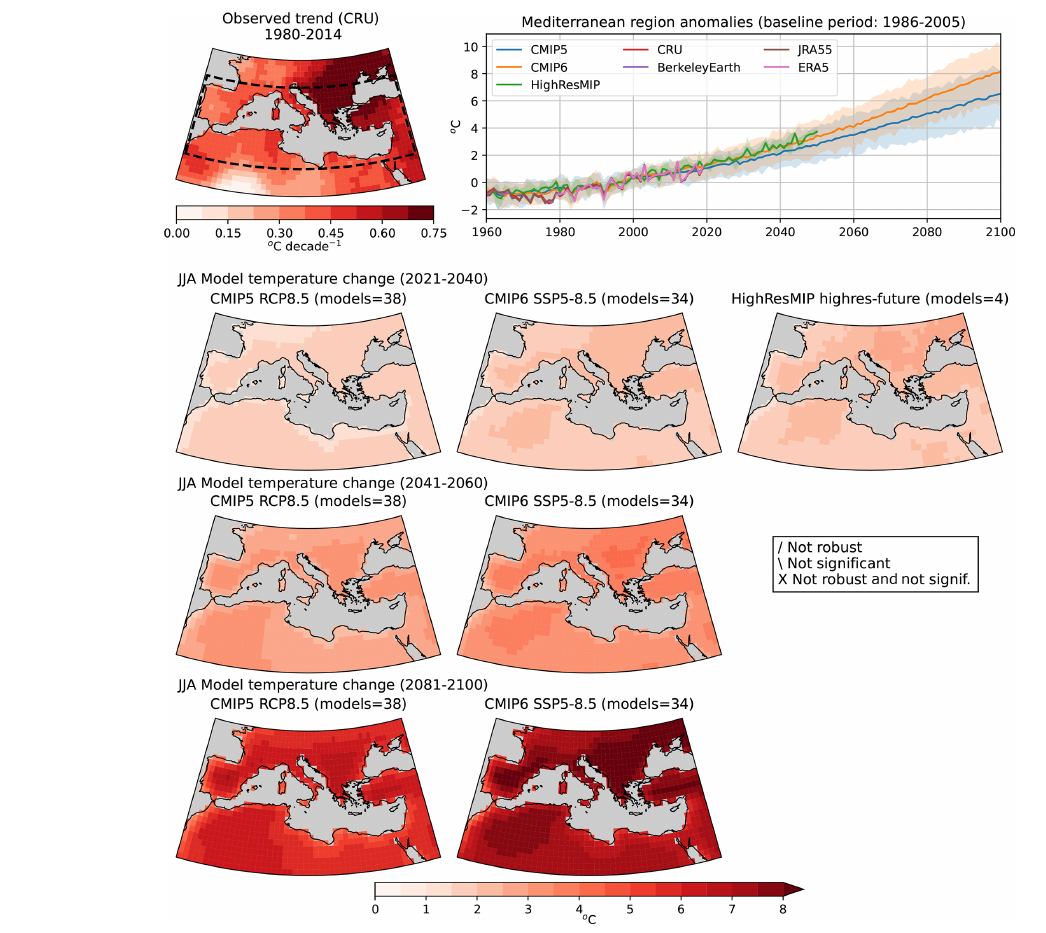
Figure 5. JJA (cid:49) TAS according to CMIP5, CMIP6 and HighResMIP ensemble means (columns) for the three relevant future periods (rows), under the RCP8.5 and SSP5-8.5 scenarios. The time series plot shows the anomalies in the Mediterranean region with respect to the period 1986–2005 for the multi-model ensembles and the observational references. A solid line indicates the one-member-per-model ensemble mean and the shaded region indicates the 5th–95th percentiles range. The CRU trend for the period 1980–2014 is shown along with the dashed line, which bounds the Mediterranean